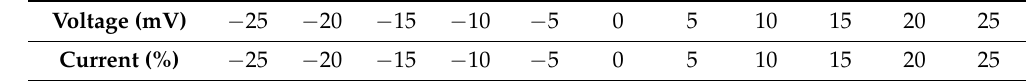
Table 2. Voltage and current drift error.